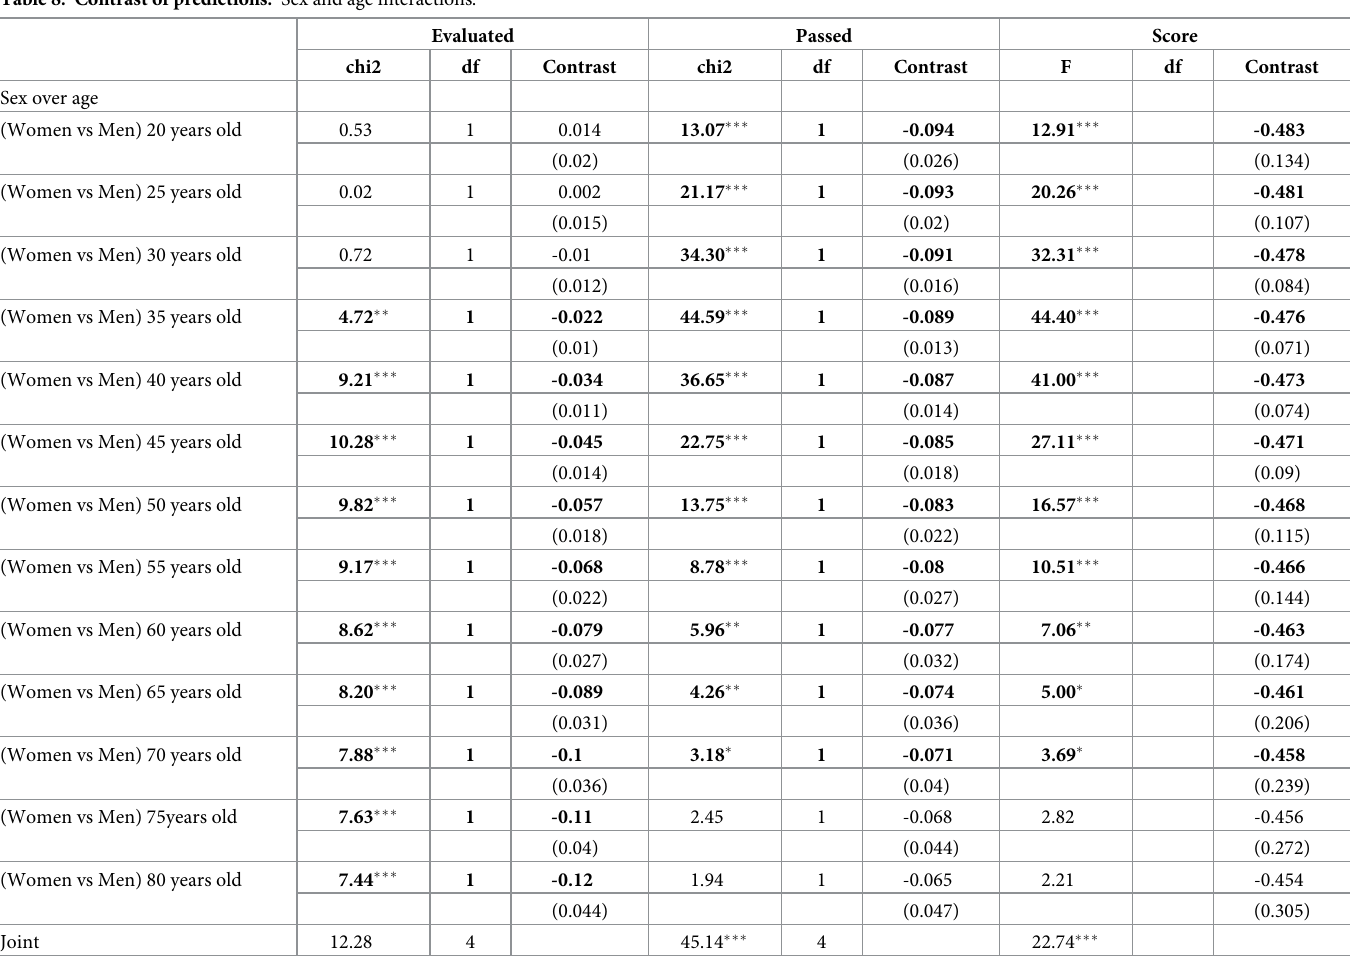
Table 8. Contrast of predictions. Sex and age interactions.